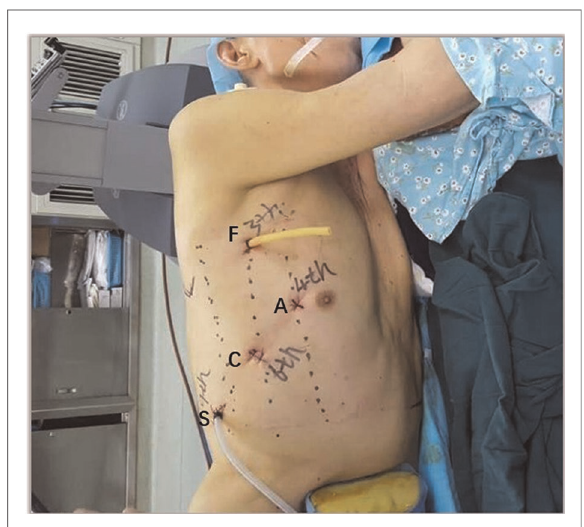
FIGURE 1 Port placement for the Da Vinci Si System using three robotic arms (thoracic cavity). C, camera port; A, assistant port; F, fi rst robotic arm; S, second robotic